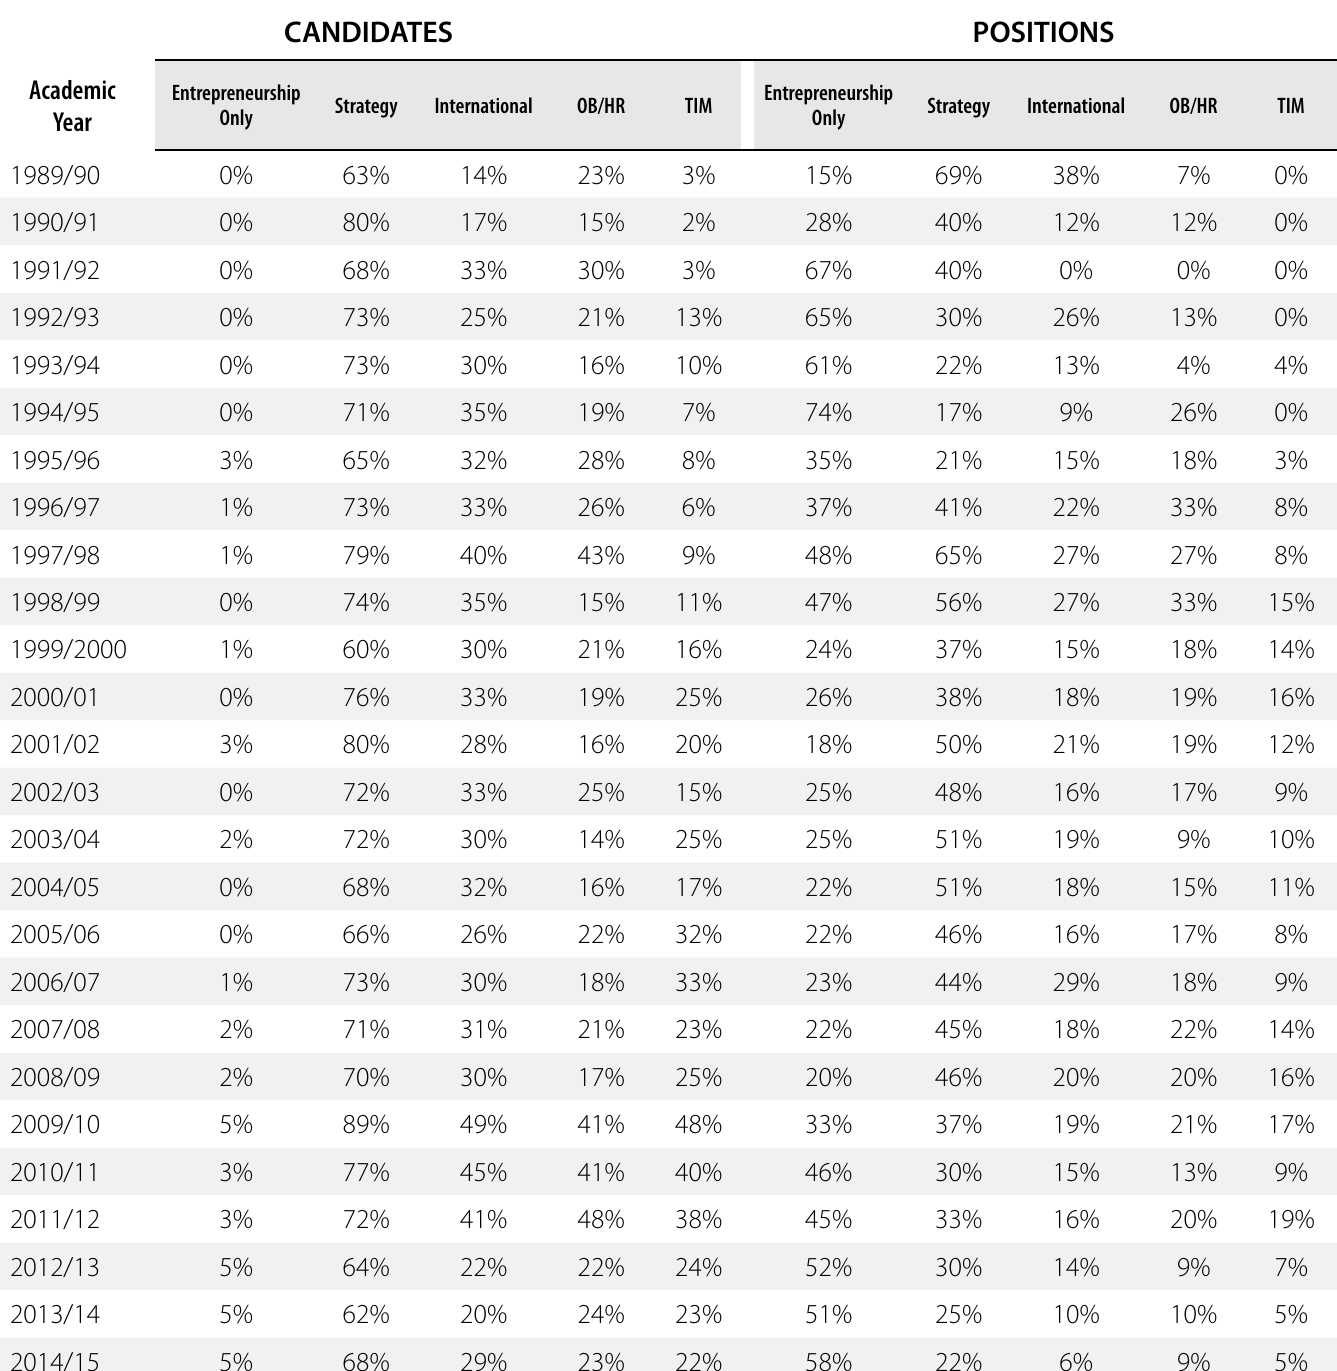
Table 4. Percentage of Applicants and Positions Cross-Listed by Field, 1989–June